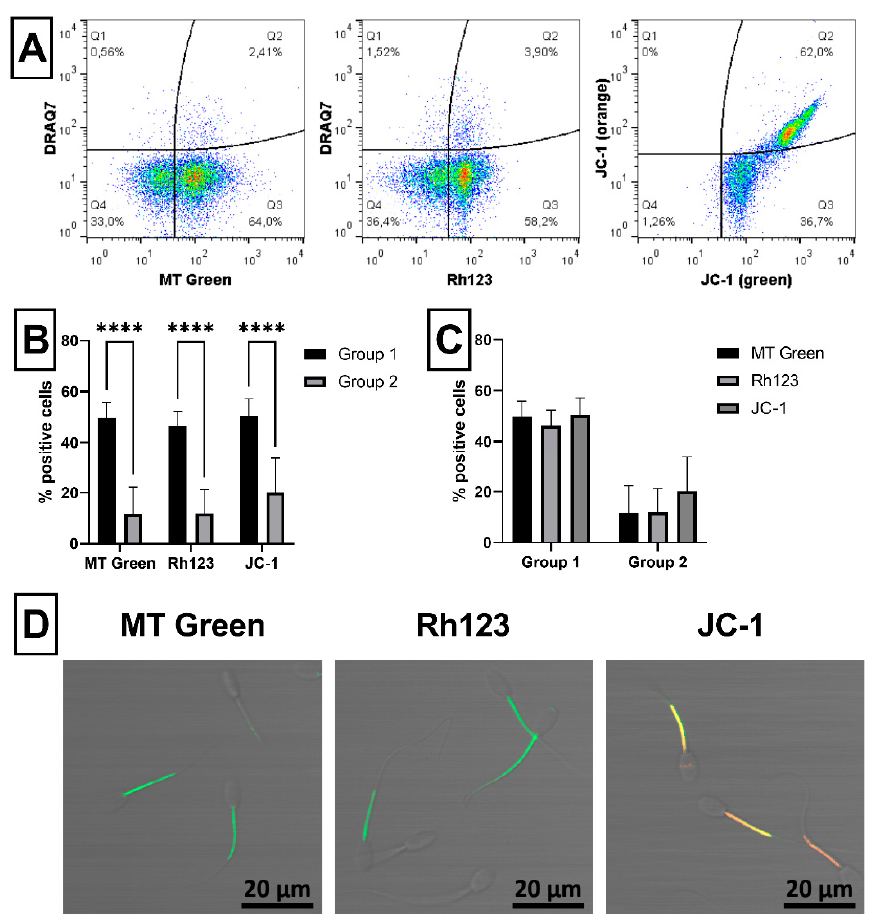
Figure 4. Evaluation of ram sperm mitochondrial activity. Illustrative flow-cytometric dot plots showing evaluation strategy of analyzed fluorescent probes. Spermatozoa gated using FSC/SSC dot plot showing dead spermatozoa in far-red FL4 channel (DRAQ7 + ) and spermatozoa with high MMP in green FL1 channel (MT Green and Rh123) or orange FL2 channel (JC-1) were divided into four quadrants (Q) according to fluorescent signals ( A ). Graph showing comparison of spermatozoa with high MMP detected using MT Green (Q3: MT Green + /DRAQ7 − ), Rh123 (Q3: Rh123 + /DRAQ7 − ), and JC-1 (Q2: JC-1 orange aggregates) in Group 1 and Group 2 ( B ). Graph comparing proportion of spermatozoa with high MMP detected using three different fluorescent probes (MT Green, Rh123 and JC-1) within each group ( C ). Illustrative images from confocal microscopy (Zeiss LSM 700) proving the specific staining of ram spermatozoa with active mitochondria (magnification at 200×, scale bar = 20 µm). MT Green and Rh123 (green), and JC-1 (orange) specifically labeled the mito- chondrial region of spermatozoa tails ( D ). Group 1—semen samples with sperm viability over 60%, Group 2—semen samples with sperm viability under 60%. The data are expressed as the means ± SD; difference is statistically significant at **** p < 0.0001.